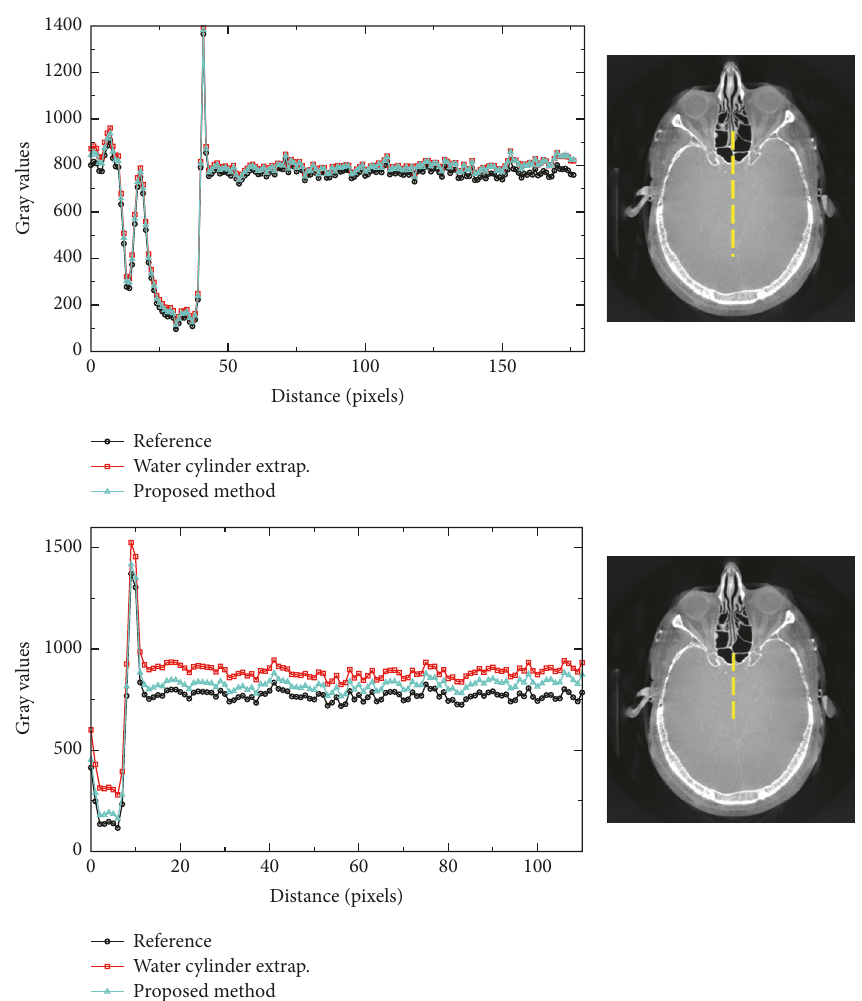
Figure 11: Plots of line profiles for each algorithm in the medium truncation case and in the severe truncation case for dataset 2. The yellow dashed line in the corresponding right image indicates the position of the line